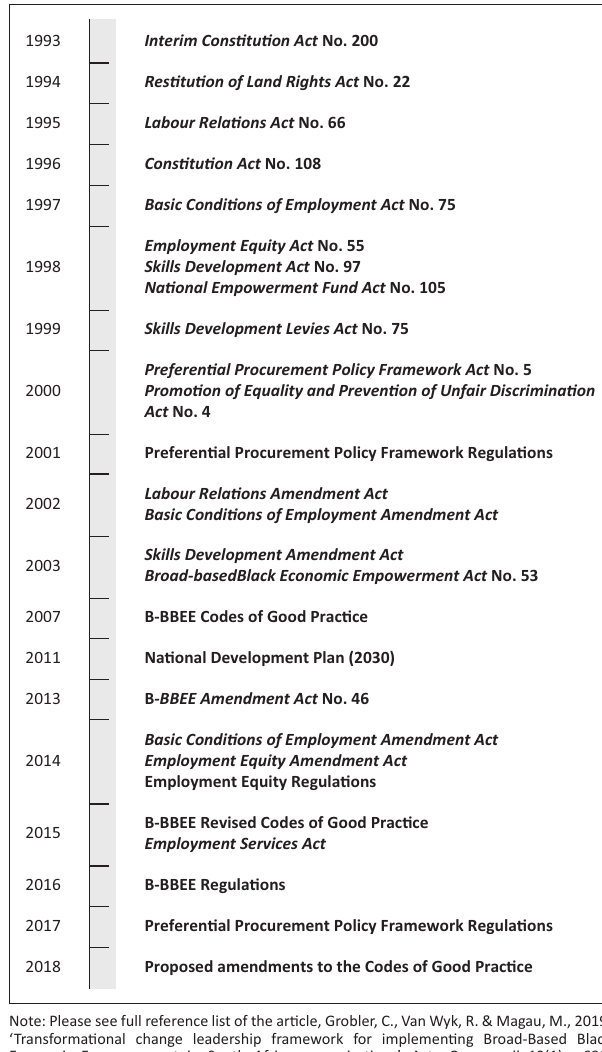
FIGURE 1: Transformation statutes and timeline of